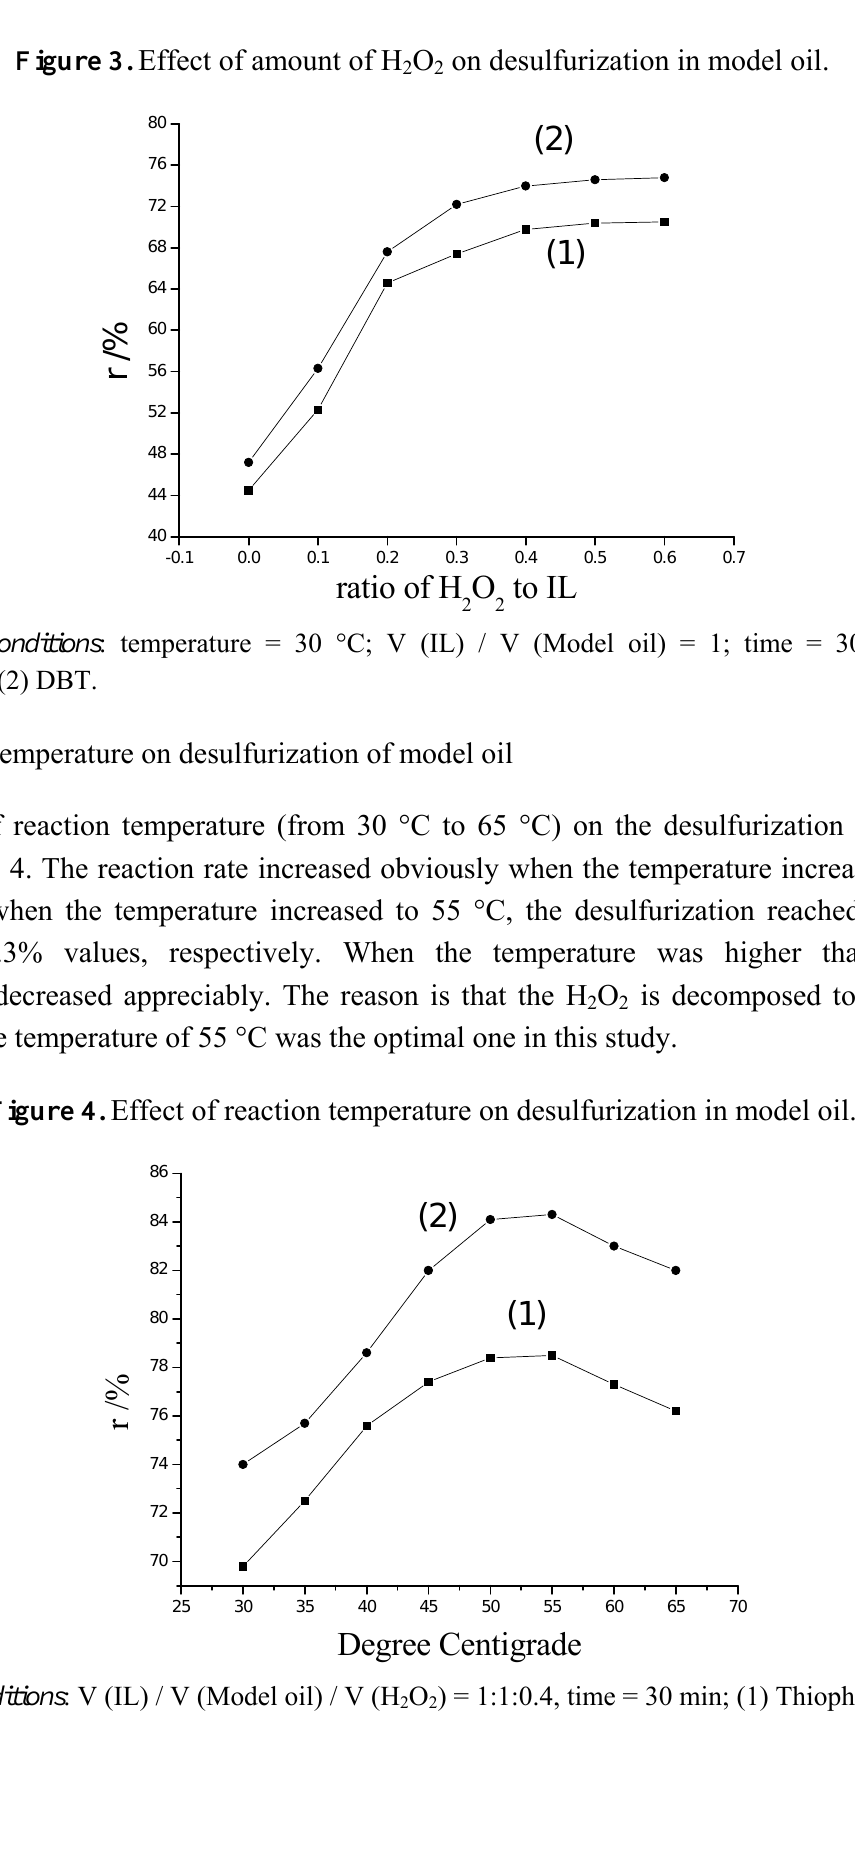
Figure 3. Effect of amount of H